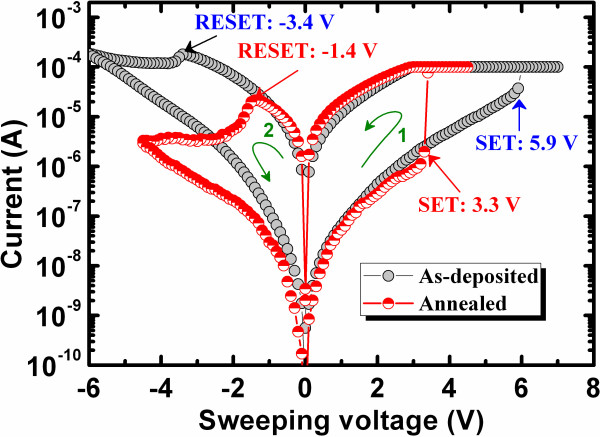
Typical I-V hysteresis characteristics of as-deposited and PMA devices with an IrOx/GeOx/W structure.